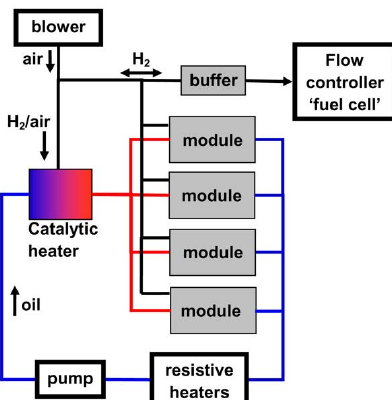
Figure 1. Process flow diagram of General Motors R&D/Sandia National Laboratories hydrogen storage system. Reprinted with permission from reference [27]. Copyright 2012 Elsevier.